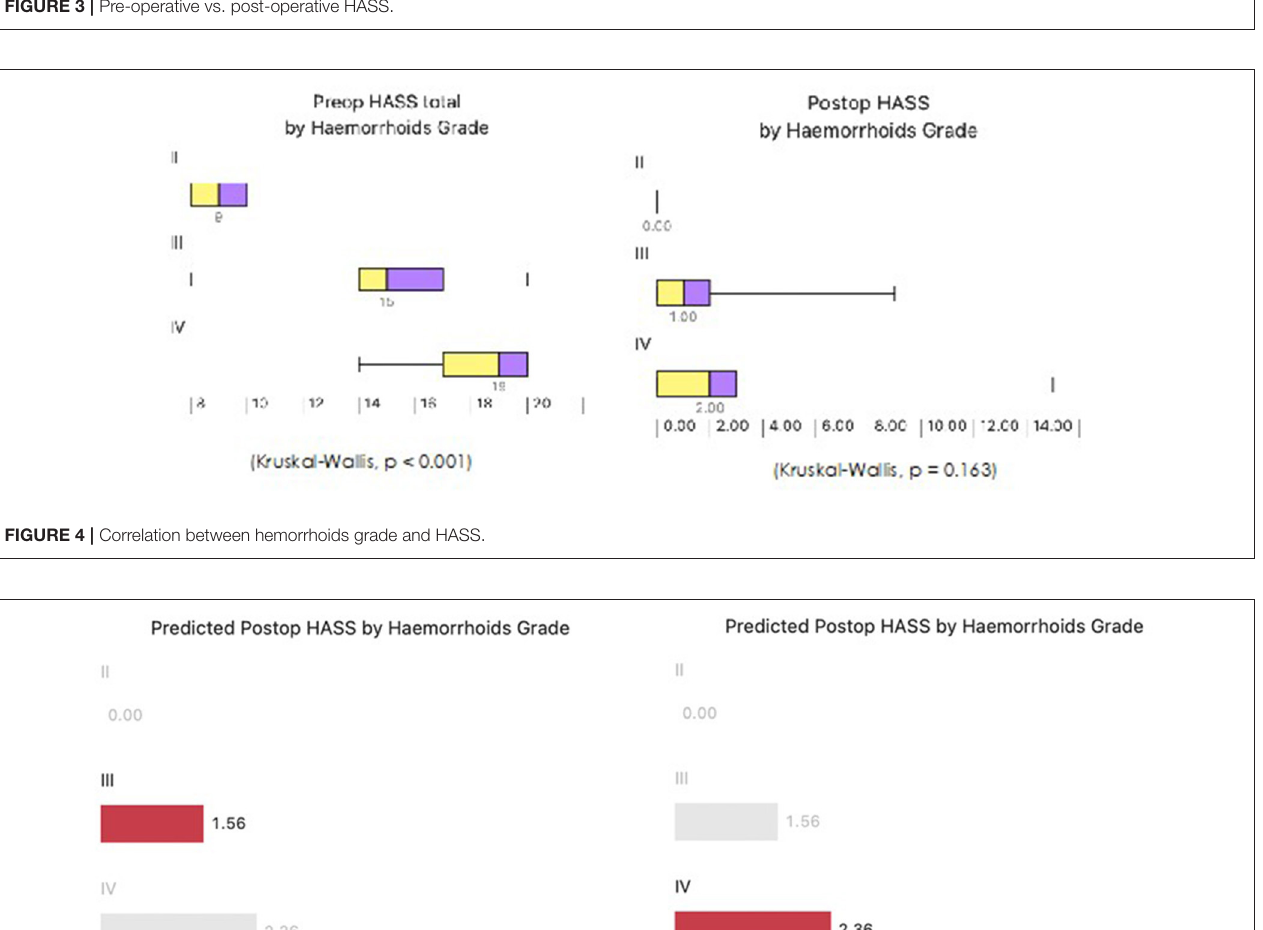
performed where the prolapsing component is most prominent, thus reducing the number of sutures needed. With this technique the length of the plication can be variable and tailored to the